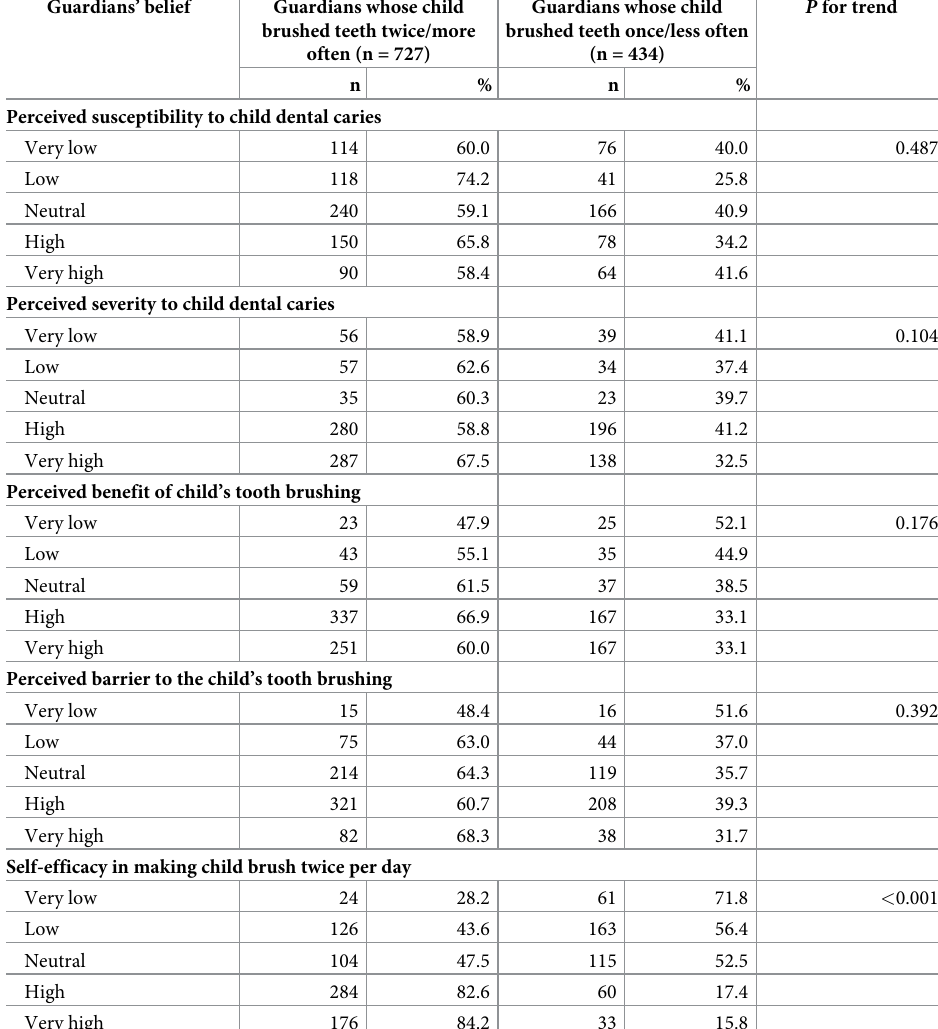
Table 3. Cross tabulation between guardians’ belief and tooth brushing behavior of their children. Guardians’